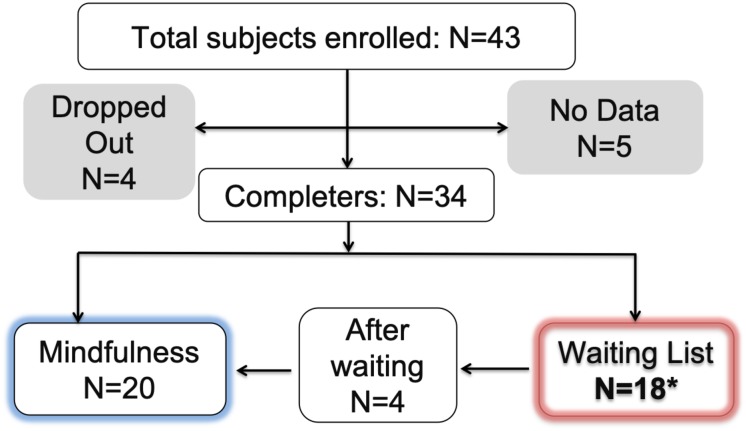
Flow chart of subject enrolment and retention.